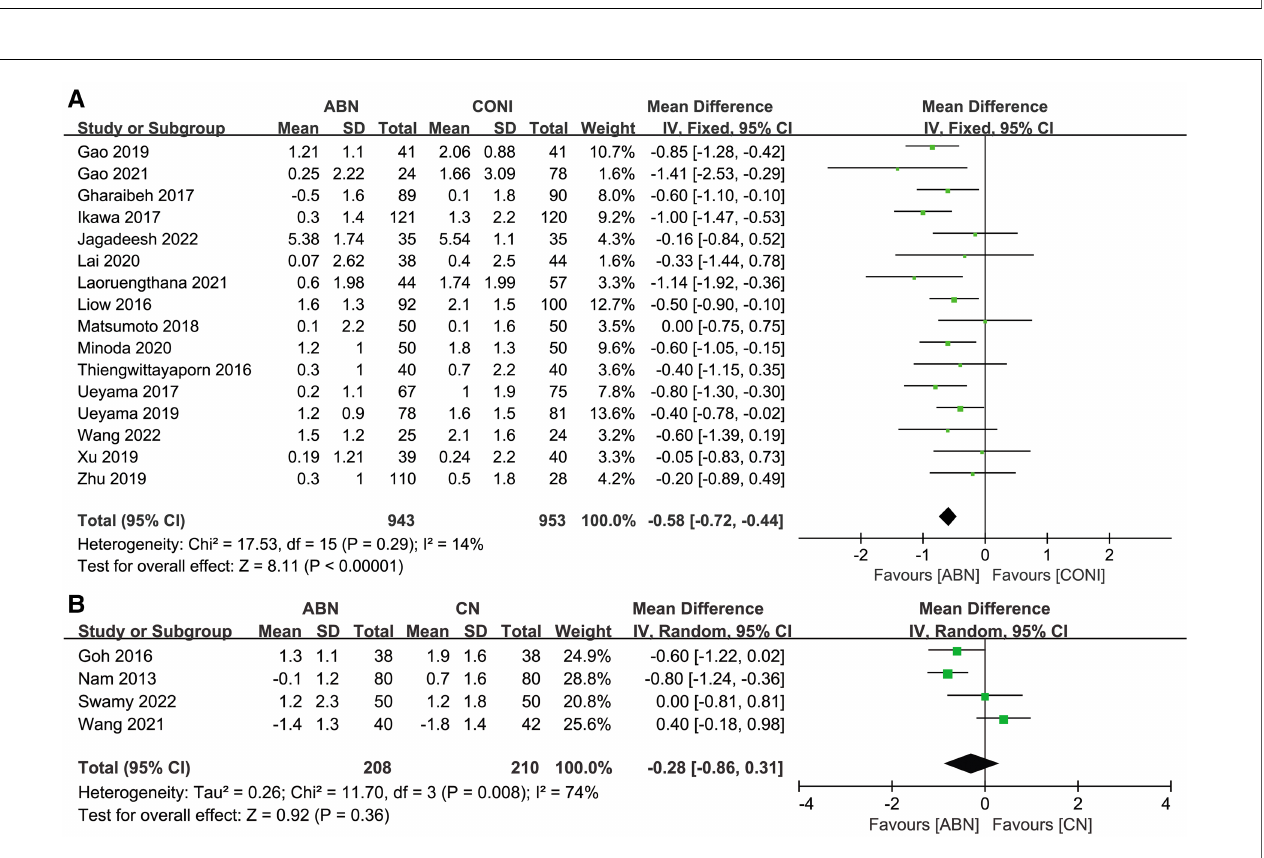
FIGURE 4 Forest plot of HKA outliers. ( A ) Accelerometer-based navigation (ABN) system vs. conventional instrumentation (CONI); ( B ) ABN system vs. computer navigation (CN) system.